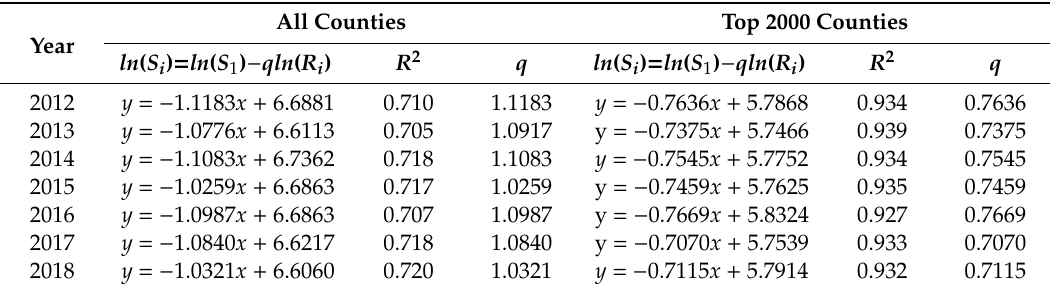
Table 4. The Zipf’s law analysis at the county level in China from 2012 to